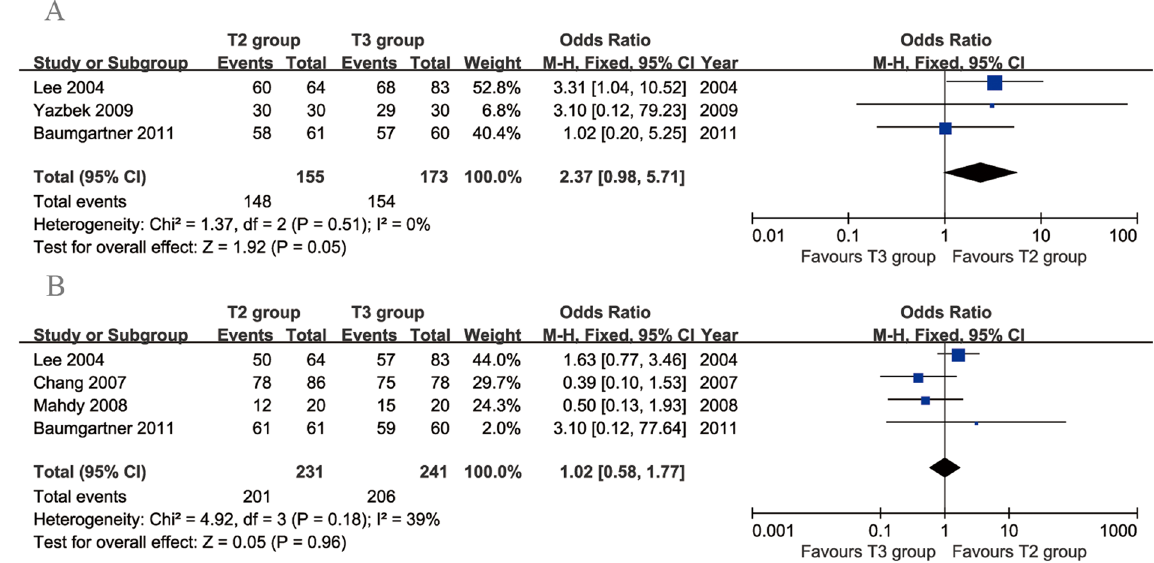
Figure 2. Forest plots for resolution of symptoms ( A ) and patient satisfaction ( B ) in the T2 and T3 groups.